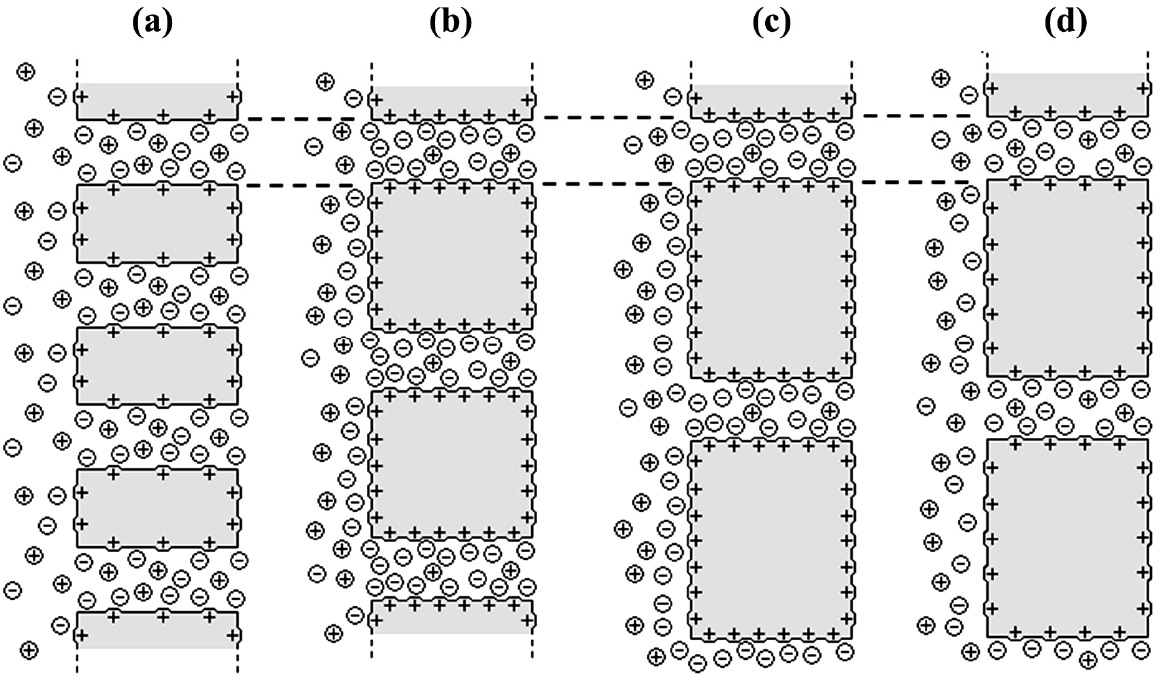
Figure 3. Illustrative representation of diffusive ion transport through membranes with different porosities and positive surface fixed charge: ( a ) Anopore (high porosity and low co-ion exclusion); ( b ) Al-Sf (medium porosity and high co-ion exclusion); ( c ) Al-Ox/Al O (low porosity and high co-ion exclusion); and ( d ) Al-Ox/SiO 2 3 and low co-ion exclusion).